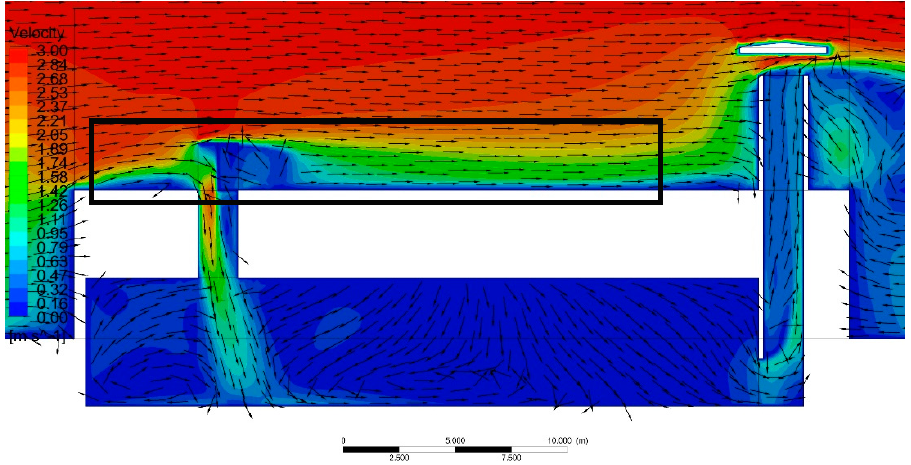
Figure 9. Air velocity color map with normalized tangential vectors on the longitudinal section of the building. The long blue and green area represents the slowed wind by the frictional losses above the roof.